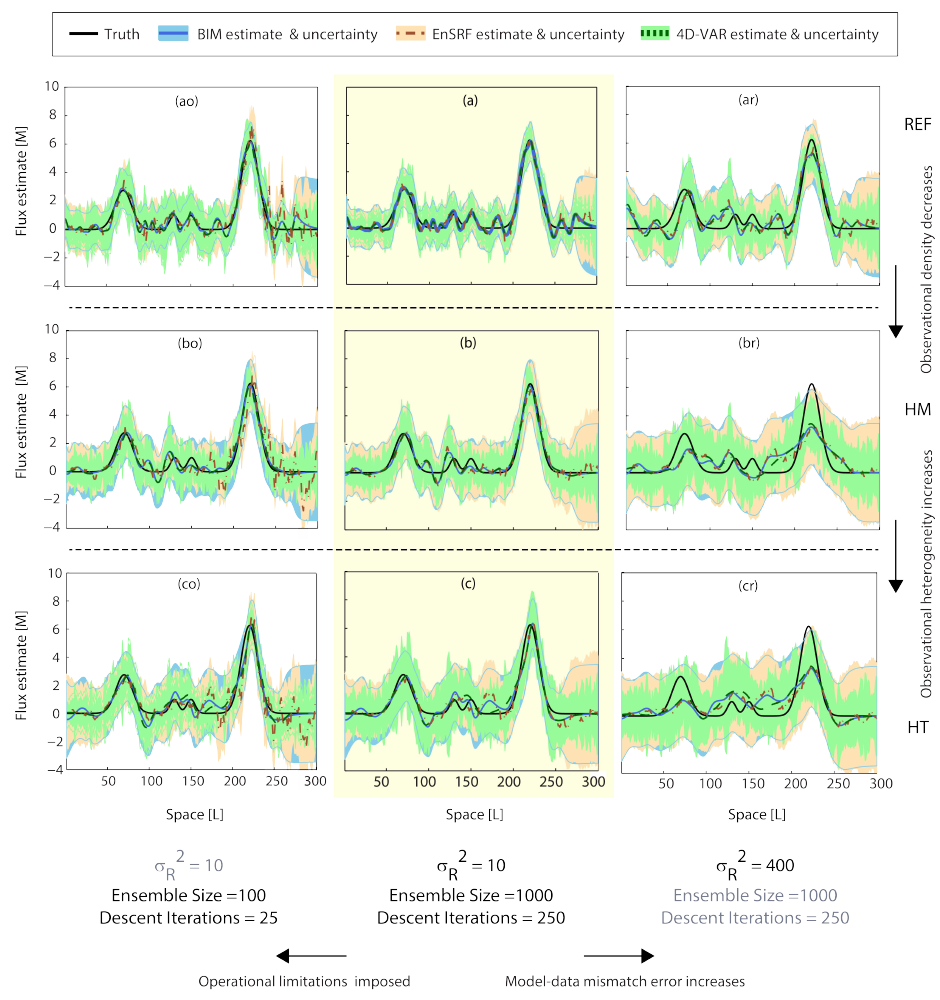
Fig. 3. Example of estimated tracer fluxes (lines) and associated ± 2 σ ˆ s uncertainties (shaded areas) for the different approaches assessed in this study. All values are shown for the 25th time period, which is representative of the observed performance over other time periods. The panel titles correspond to the different experiments outlined in Table